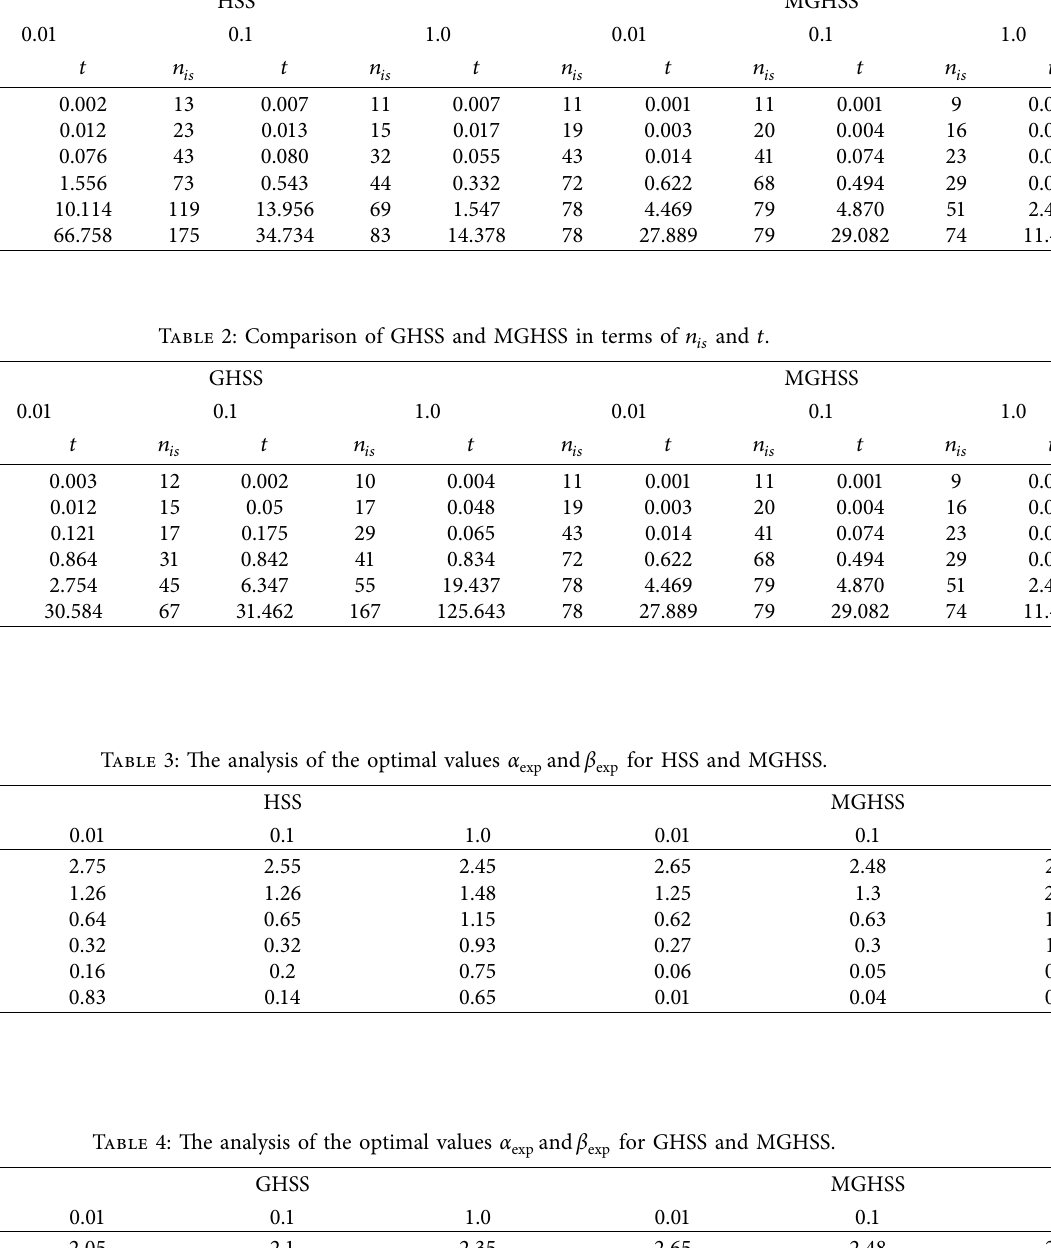
Table 1: Comparison of HSS and MGHSS in terms of n